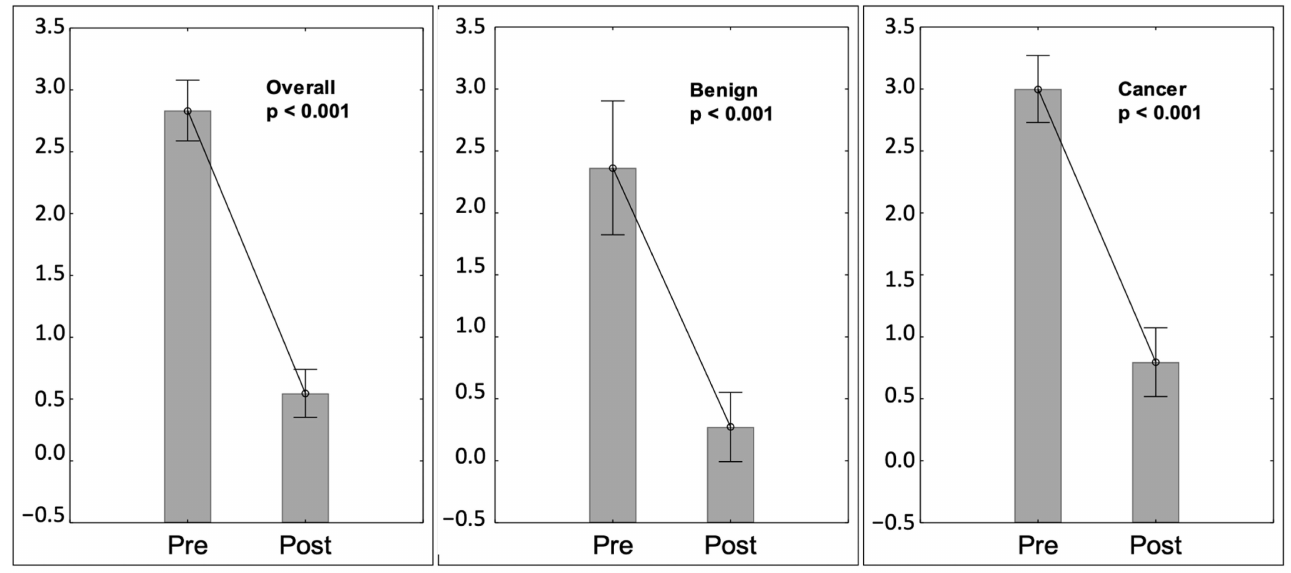
Figure 1. Dysphagia. Pre—prior to procedure, Post—two days after the procedure. There was no significant effects of age, sex, histopathologic diagnosis, and nutritional status (BMI, NRS 2002 score, GLIM, and degree of dysphagia) on complication rates after esophageal stent placement. A stent diameter of < 2.2 cm compared with ≥ 2.2 was associated with a higher rate of migrations (15.5% vs. 2.5%) (Tables 2 and 3). Table 2. Influence of patients’, stent, and tumor characteristics on